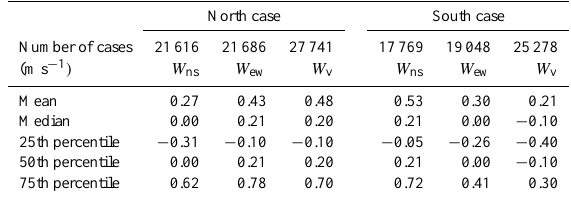
Table 1. Statistical results from the north and south case studies.